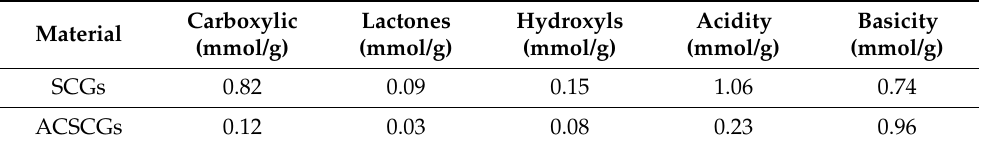
Table 3. Surface functions of SCGs and ACSCGs.